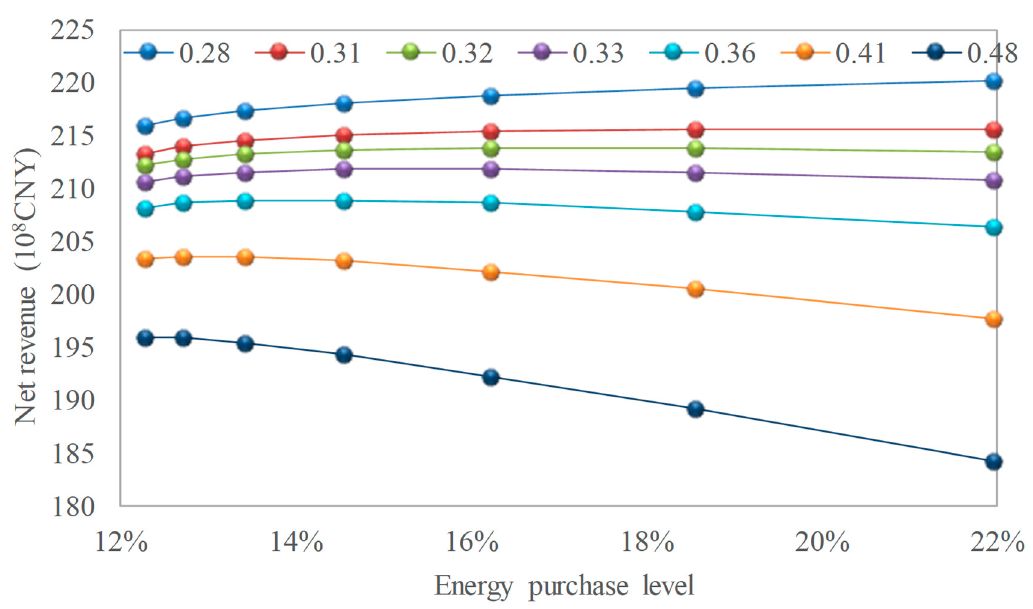
λ and energy purchase levels. Figure 7. Net revenue results under different values of